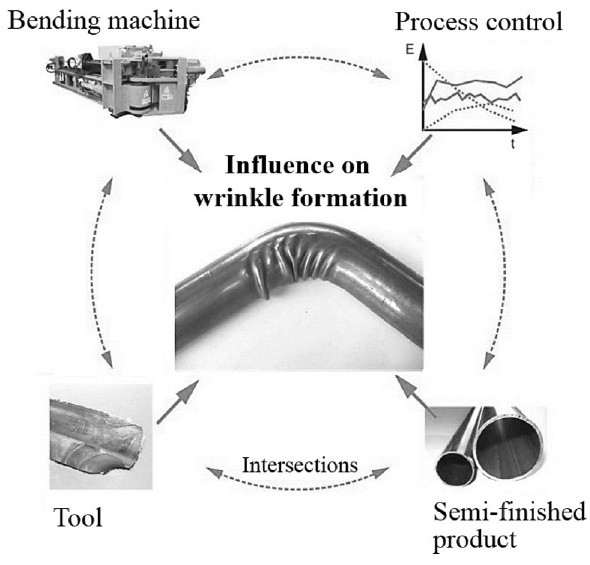
Fig. 2 Influence on wrinkle formation Engel and Mathes [10]